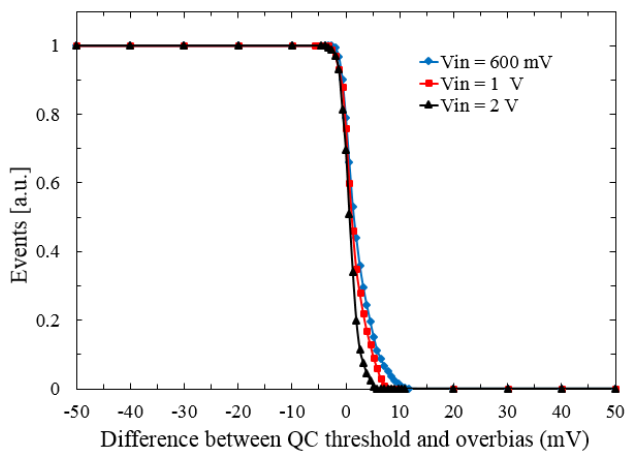
Figure 14. Operational amplifier S-curve of the discrimination.